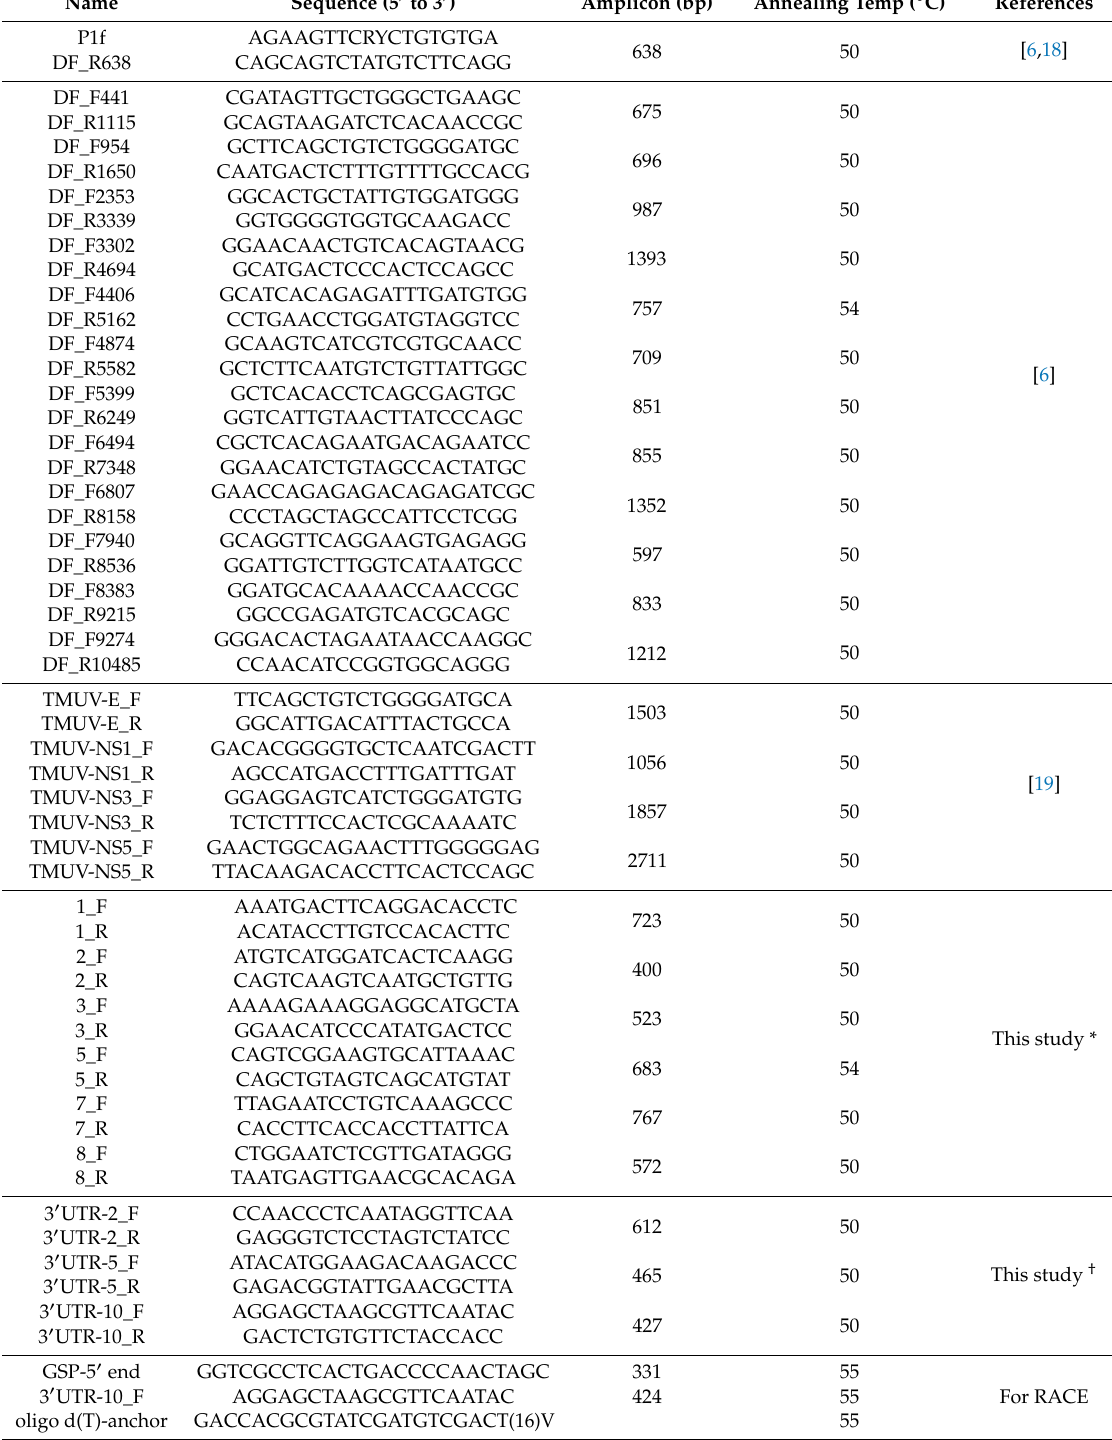
Table 1. Primers used in RT-PCR and DNA sequencing for